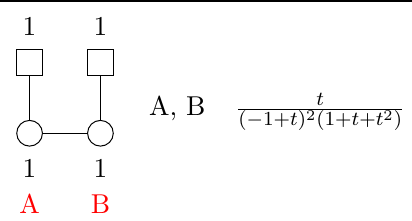
Table 12. E 3 family for k = 1 . B-twisted index with Wilson lines at the labelled position in the quiver.